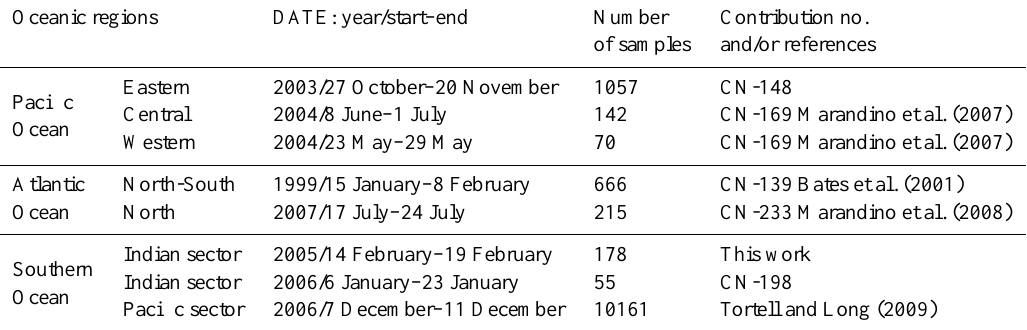
Fig. 1. DMS transects used in this study in conjunction with ocean color and PGD data. Details regarding the data sets can be found in Table 1. The color background is Chl climatology (2002–2007) from the MODIS AQUA sensor. Table 1. Sea surface DMS datasets used in this study. Oceanic